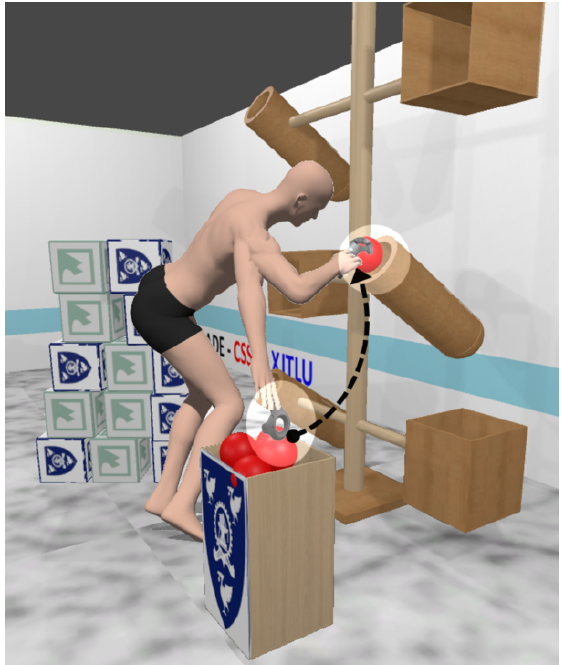
Figure 1. A screenshot of the task based VR environment. The environment was designed to elicit task based movements of users that allowed for biometric identification. Participants would perform movements that were primitively elliptical. In the above example, the user needed to relocate the ball from the bin to the